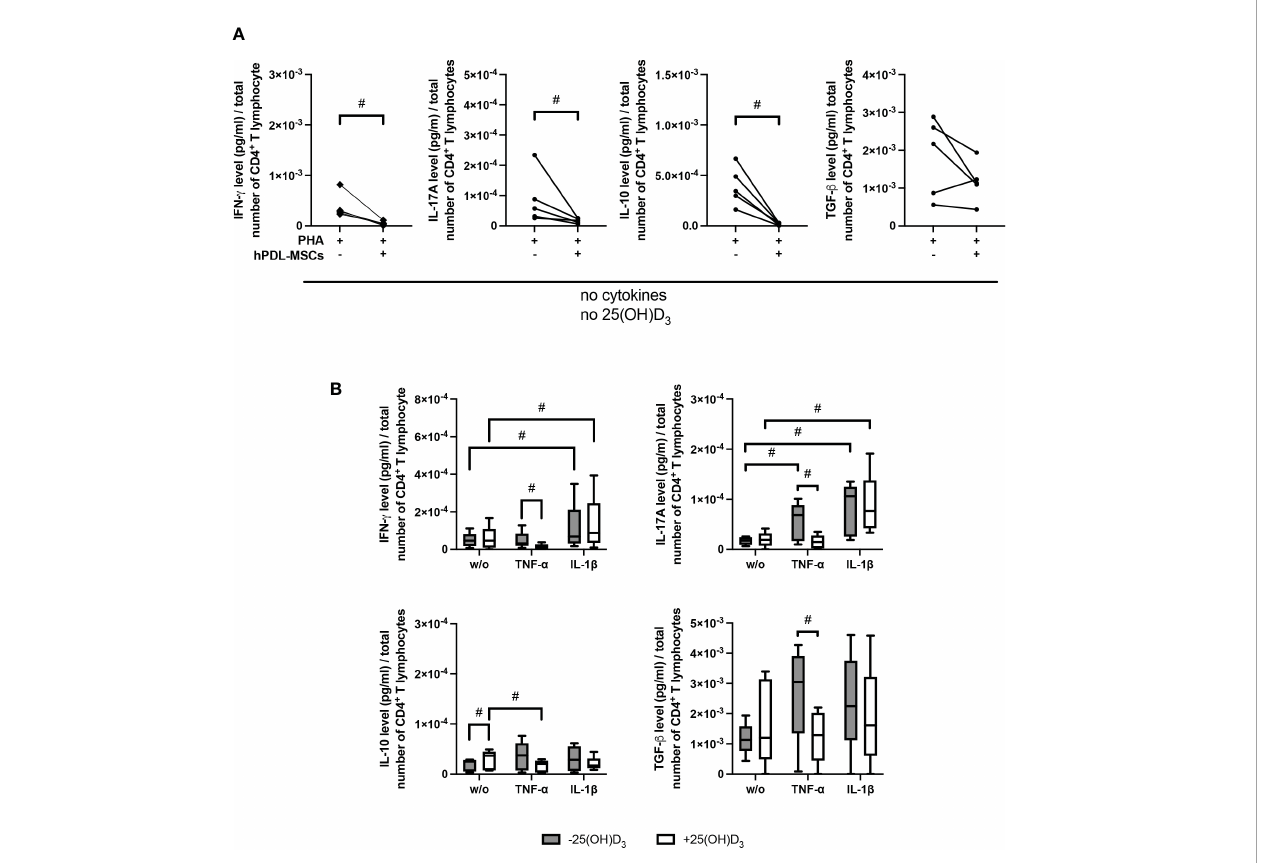
FIGURE 3 25(OH)D 3 differently affects the production of IFN- g , IL-17A, IL-10, and TGF- b in CD4 + T lymphocytes via hPDL-MSs treated with various pro- in fl ammatory cytokines. After fi ve days of culturing CD4 + T lymphocytes indirectly with hPDL-MSCs, the concentration of Th1 (IFN- g ), Th17 (IL-17A), and regulatory T lymphocytes (IL-10, TGF- b ) cytokines were measured in conditioned media using appropriate enzyme-linked immunosorbent assays (ELISA) and the total CD4 + T lymphocyte numbers per sample were determined using a cell counting chamber. Measured cytokine levels (pg/ml) were normalized to the total CD4 + T lymphocyte number. Data were obtained from fi ve (A, B) experimental repetitions using hPDL-MSCs from a different individual per repetition. One technical replicate was used per experimental group. In (A) the normalized cytokine levels are represented as an individual line for each experimental repetition, whereas in (B) data are presented as a box-whisker-plot showing the minimum and maximum values. The Friedman test, followed by the Wilcoxon test, was used for pairwise comparison. # p-value < 0.05 were considered to be statistically signi fi cant between groups as